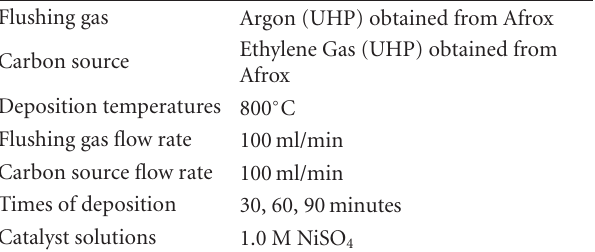
Table 1: Parameters employed for carbon nanotube growth via CVD using spray